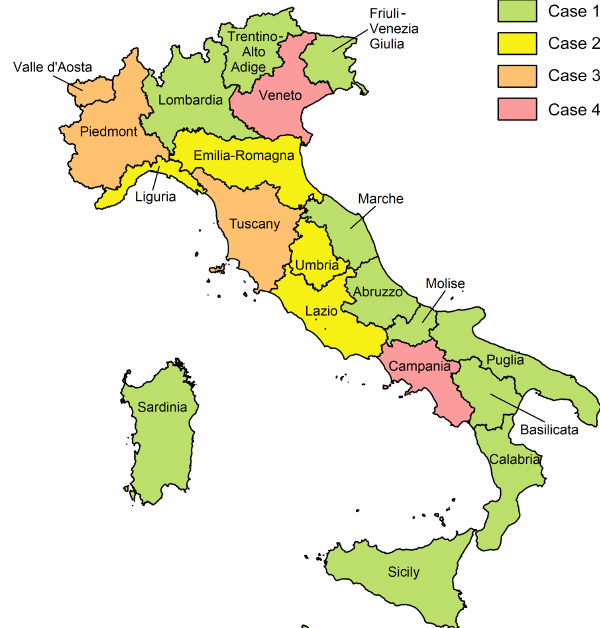
Figure 1. Names of the Italian regions and type of datasets pro- vided by the regional authorities. The cases refer to the bullet list of Sect.